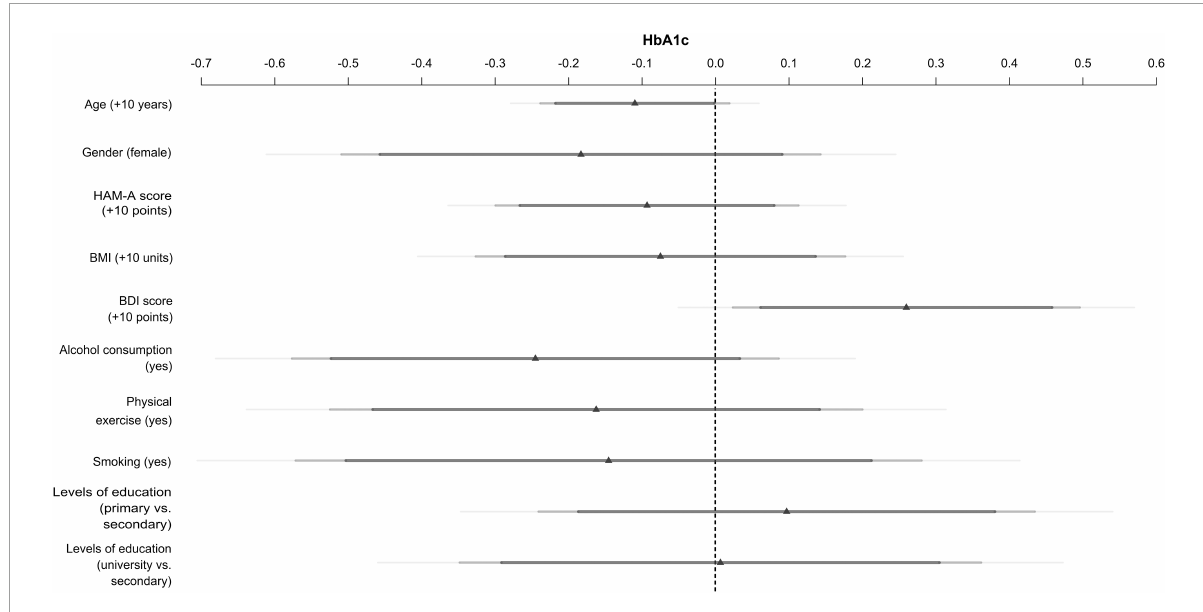
FIGURE1 Impact of depressive (BDI score) and anxiety (HAM-A score) symptoms on HbA1c, controlling for age, gender, Body Mass Index (BMI), alcohol consumption, physical exercise, smoking, and levels of education in patients with type 2 diabetes using multivariable linear regression (Hungary, n = 338, 2018–2020).